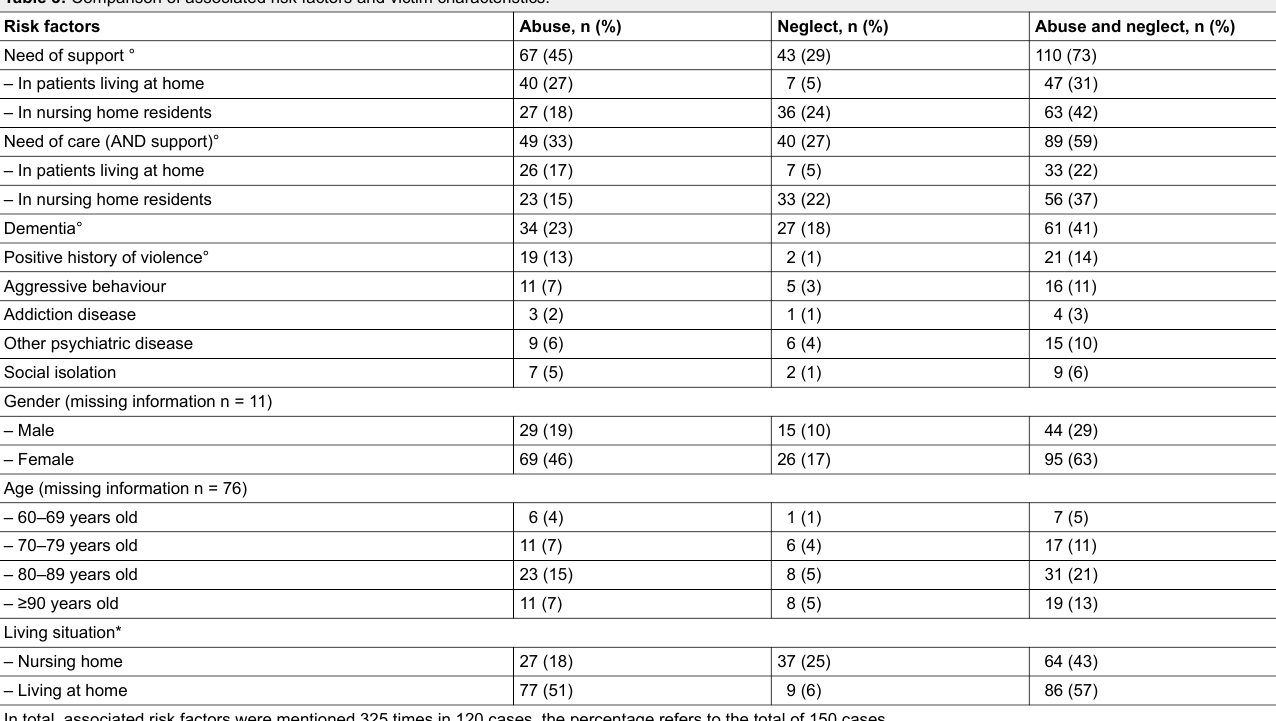
Table 3: Comparison of associated risk factors and victim characteristics.